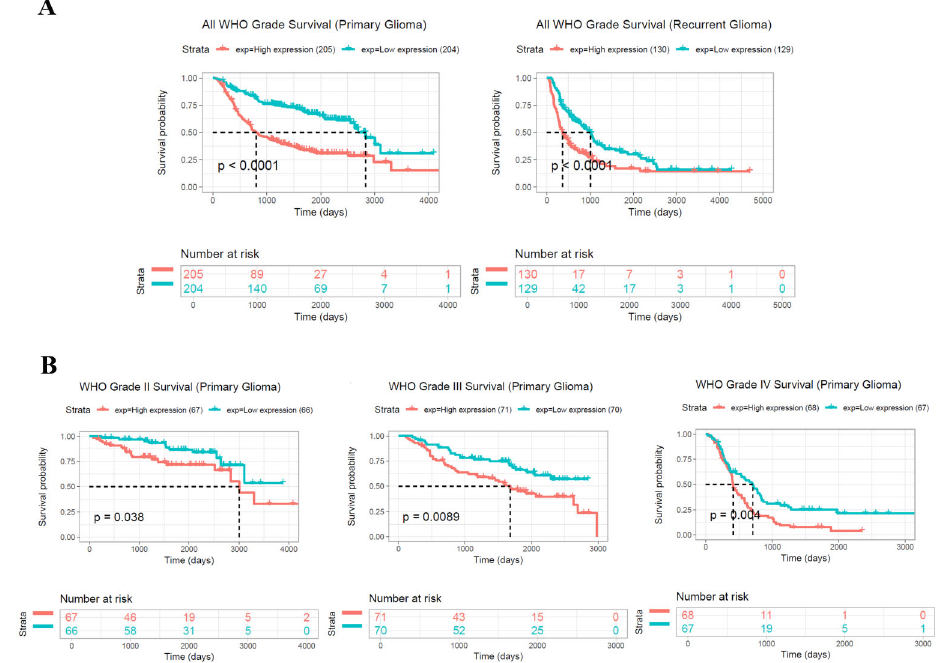
Figure 2. The higher the MARVELD1 expression, the lower the survival rate in all WHO II, WHO III, and WHO IV grades. A , Survival curves of primary glioma and recurrent glioma based on all WHO grades. B , Survival curves of primary glioma based on WHO II, WHO III, and WHO IV grades. Data are reported as means ± SD. P o 0.01 (Student ’ s t -test or one-way ANOVA with Dunnett ’ s